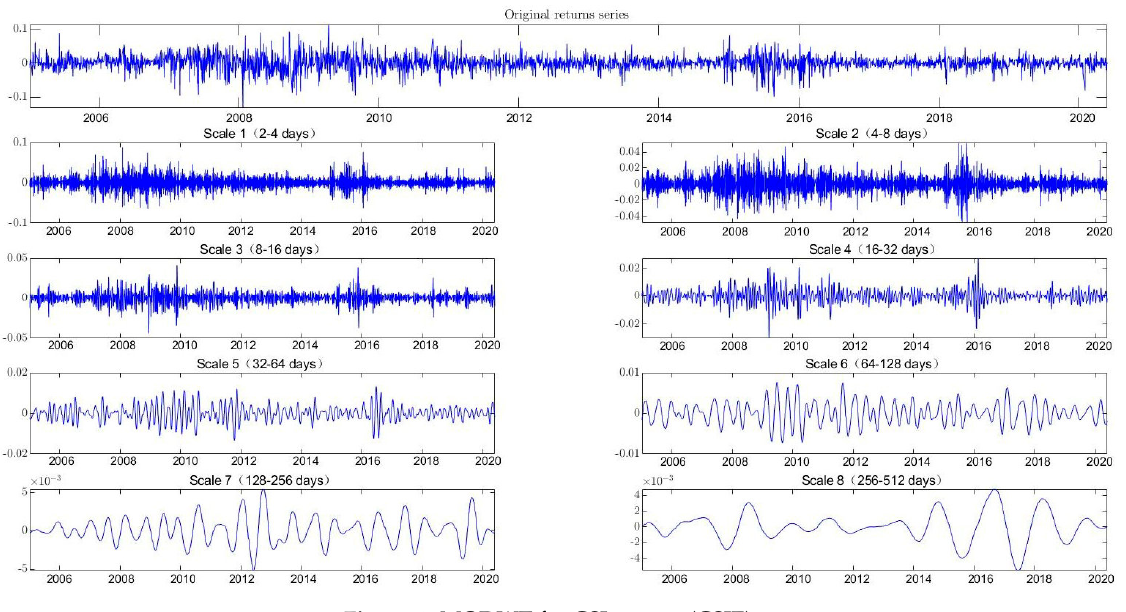
Figure 3. MODWT for the Shanghai Composite Index (SSEC).